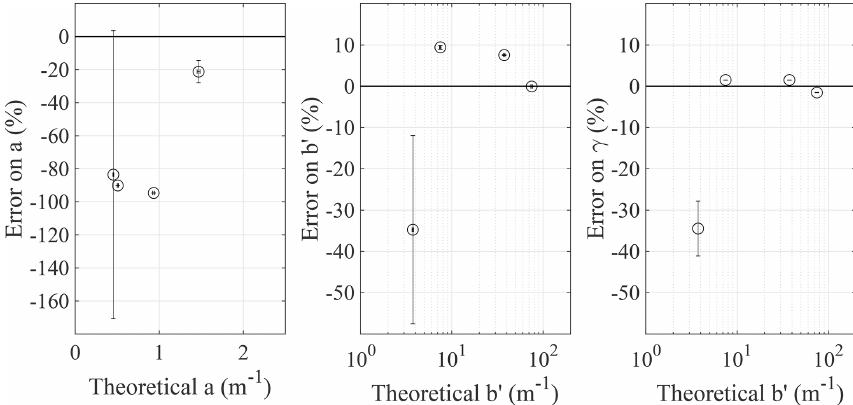
Figure 7. Validation of IOP measurements using reference media. The reference media were four solutions of polystyrene microspheres in distilled water. Microsphere concentrations were chosen for the theoretical a and b (cid:48) ranges to cover sea ice typical values. Detecting fibres 1 and 7 were taken out for optimized